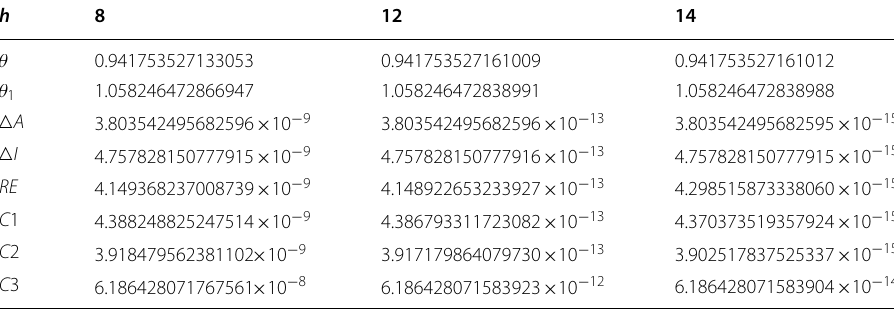
Table 2 Summary Results for Example 5 on Theorems 6 and